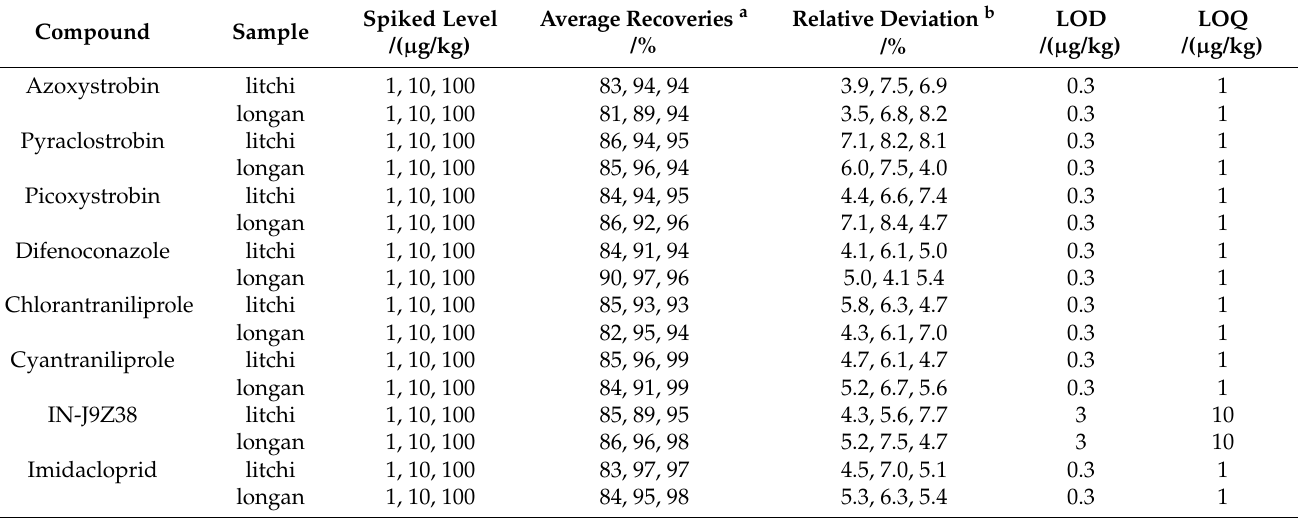
Table 4. Recoveries, RSDs, LOD, and LOQ of eight targeted compounds in litchi and longan samples ( n = 5).